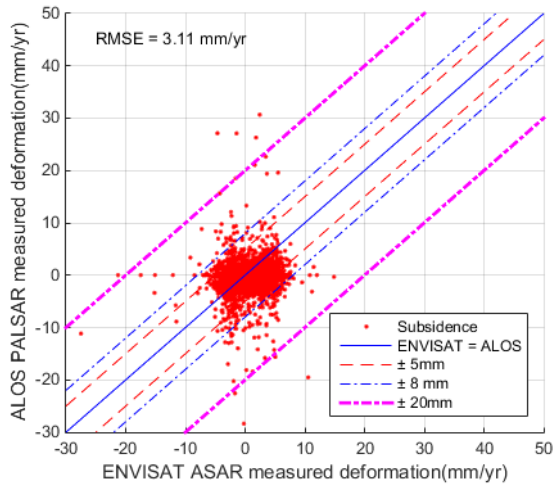
Figure 3. L-band ( a ) and C-band ( b ) measurement over Wollongong city region in vertical direction ( c ) time series evolution over one MP pixel marked with red cross.